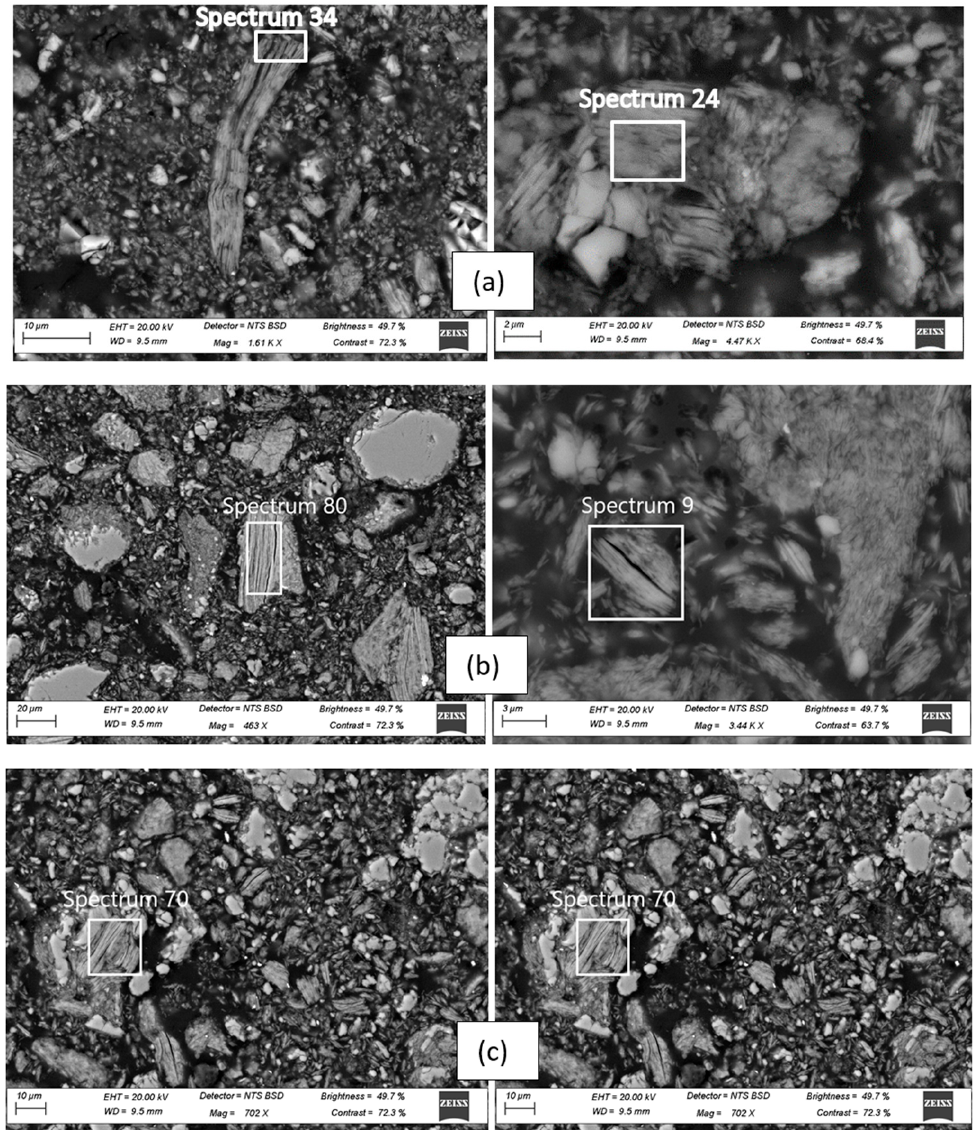
Figure 5. SEM images of clay samples at two levels of magnification: ( a ) EXW, ( b ) BFN, ( c ) MFN.